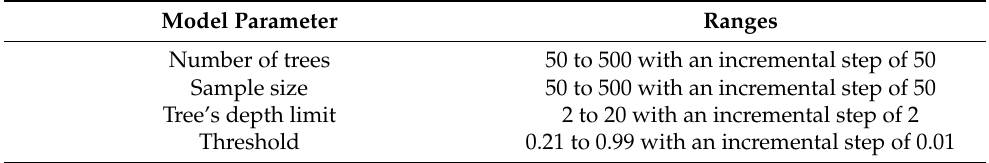
Table 3. Parameter range of each variable used in the grid search of the EIF and IF models.